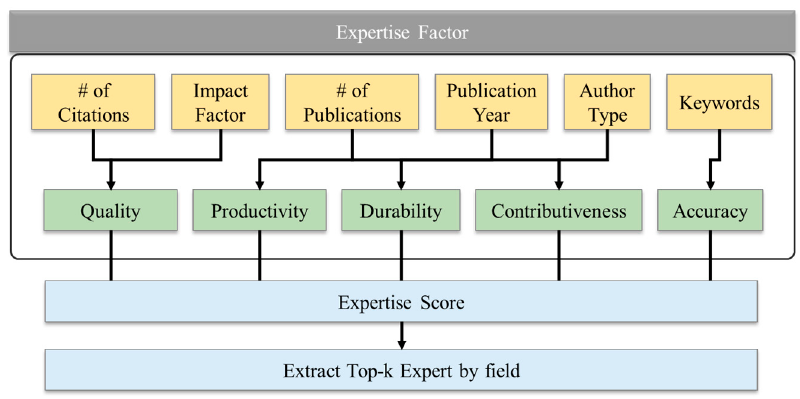
Figure 5. Expertise